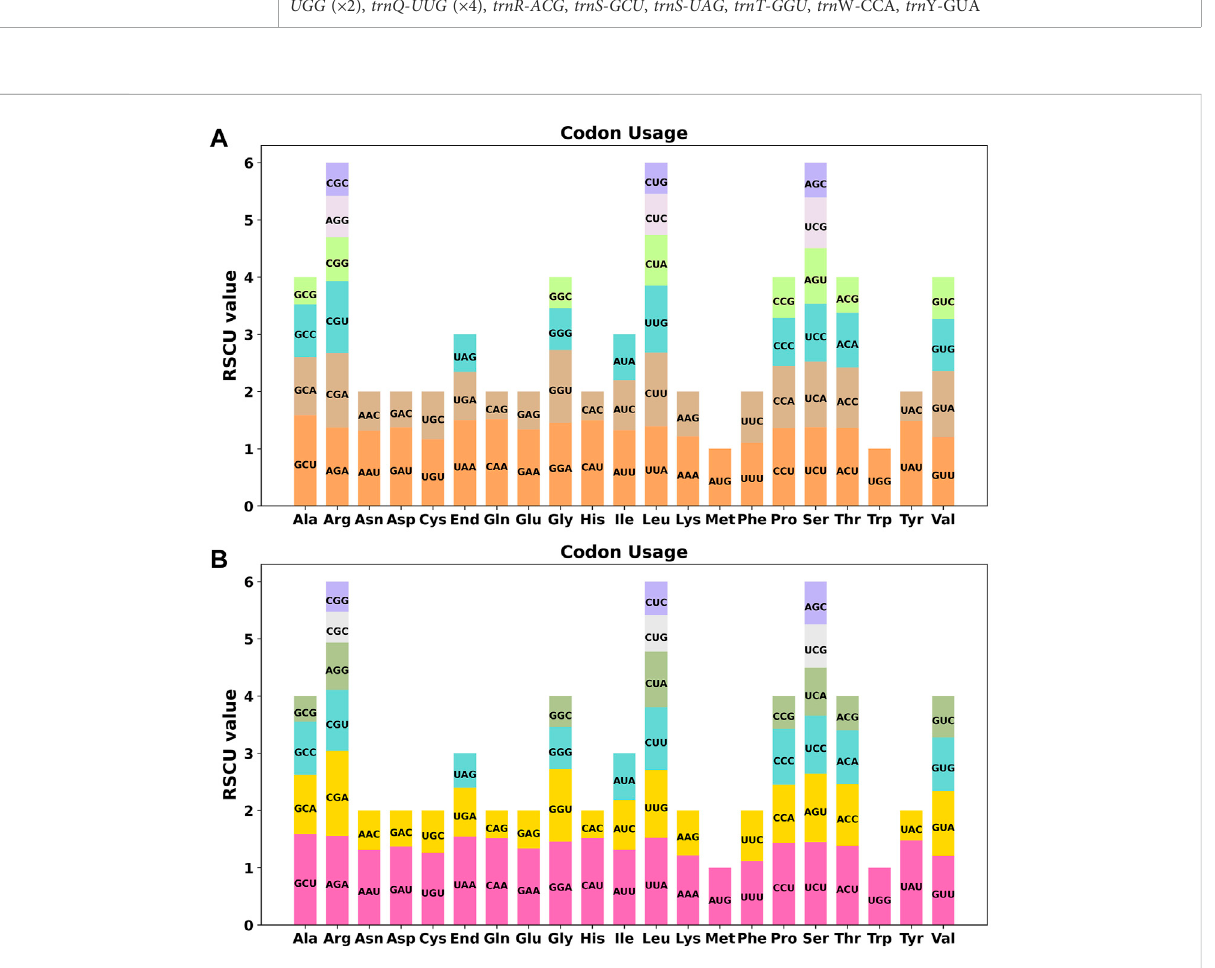
FIGURE 3 C.acerifolia mitogenomerelativesynonymouscodonusage(RSCU). (A) BeforeRNAediting. (B) AfterRNAediting.Codonfamiliesareshownon the x-axis. RSCU values are the number of times a particular codon is observed relative to the number of times that codon would be expected for a uniform synonymous codon